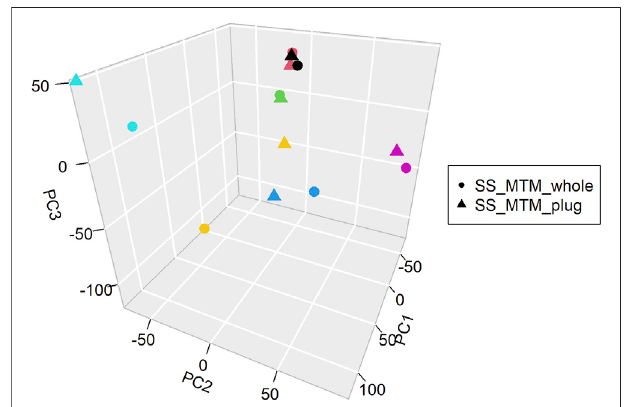
FIGURE2| Principal component analysis(PCA) oftheRNA-seq dataset for SS_MTM_plugs and SS_MTM_whole samples. Each color represents a paired sample (plug and